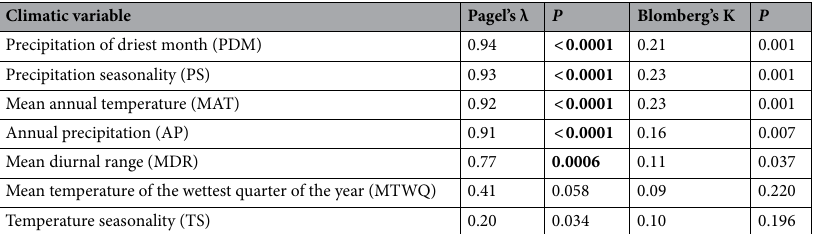
Table 1. Output of the phylogenetic signal tests for the climatic variables and climatic niches (Pagel’s λ and Blomberg’s K). The climatic variables are ordered from the highest to the lowest values of Pagel’s λ. In bold, significant values ( P < 0.05) after applying the Holm–Bonferroni